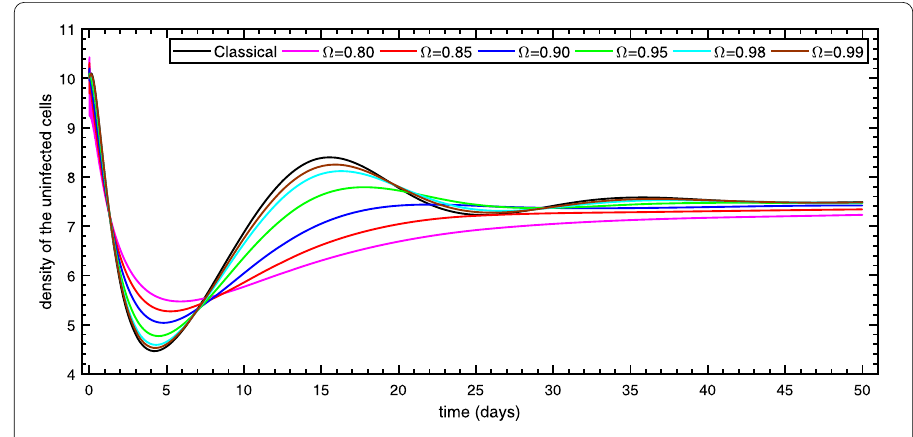
Figure 1 Density of the uninfected cells with initial conditions X (0) = 10, Y (0) = 10, V (0) = 0 for t ∈ [0,50]